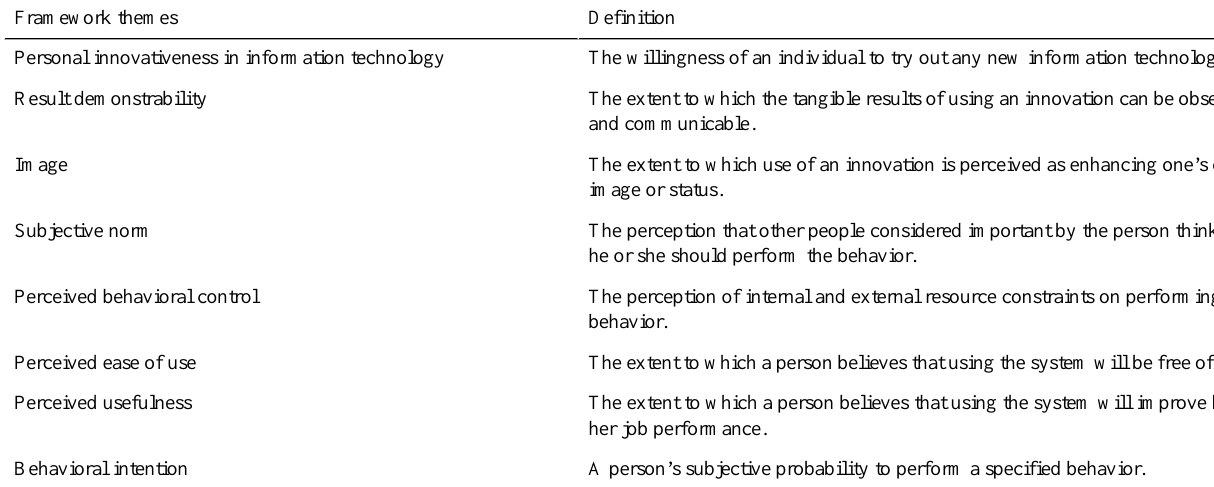
Table 1. Outline of the themes included in the integrative model of technology acceptance among professionals [16], which were used in the framework analyses of the